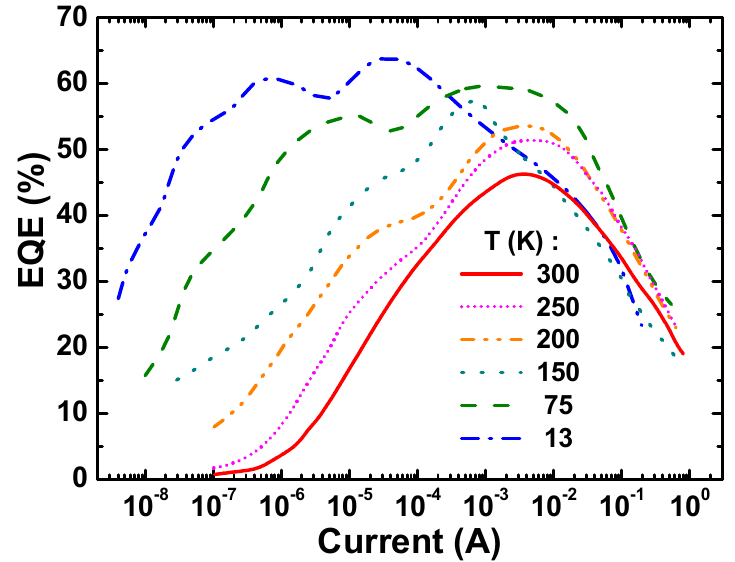
Figure 3. External quantum efficiency (EQE) of green LEDs versus driving current measured at various temperatures.